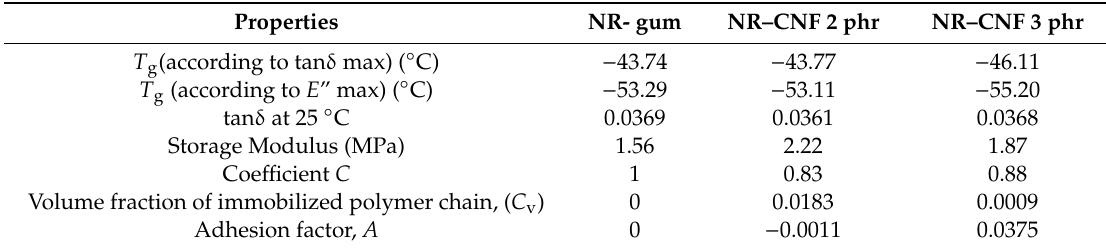
Table 7. Dynamic mechanical analysis data of NR gum and NR–CNF